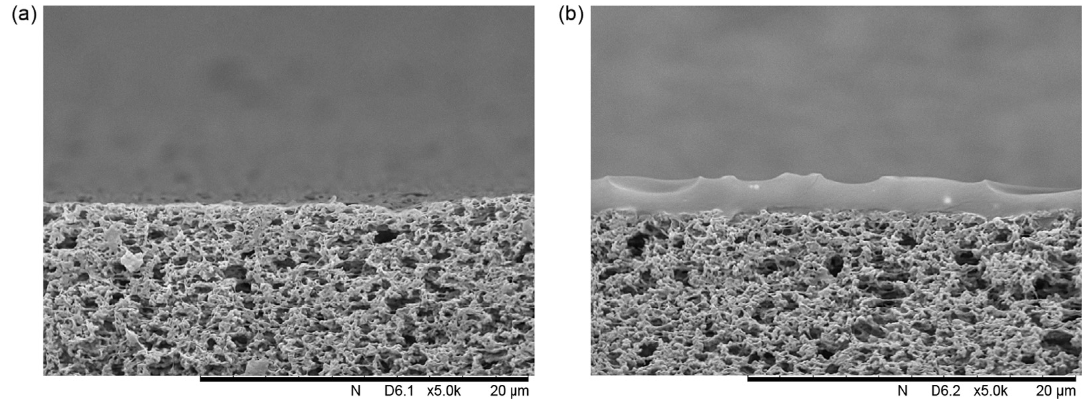
Figure 3. SEM image of: ( a ) Non-modified microfiltration membrane (MFFK-1), ( b ) composite poly(1-trimethylsilyl-1-propyne) (PTMSPM) with MFFK-1 support [17].